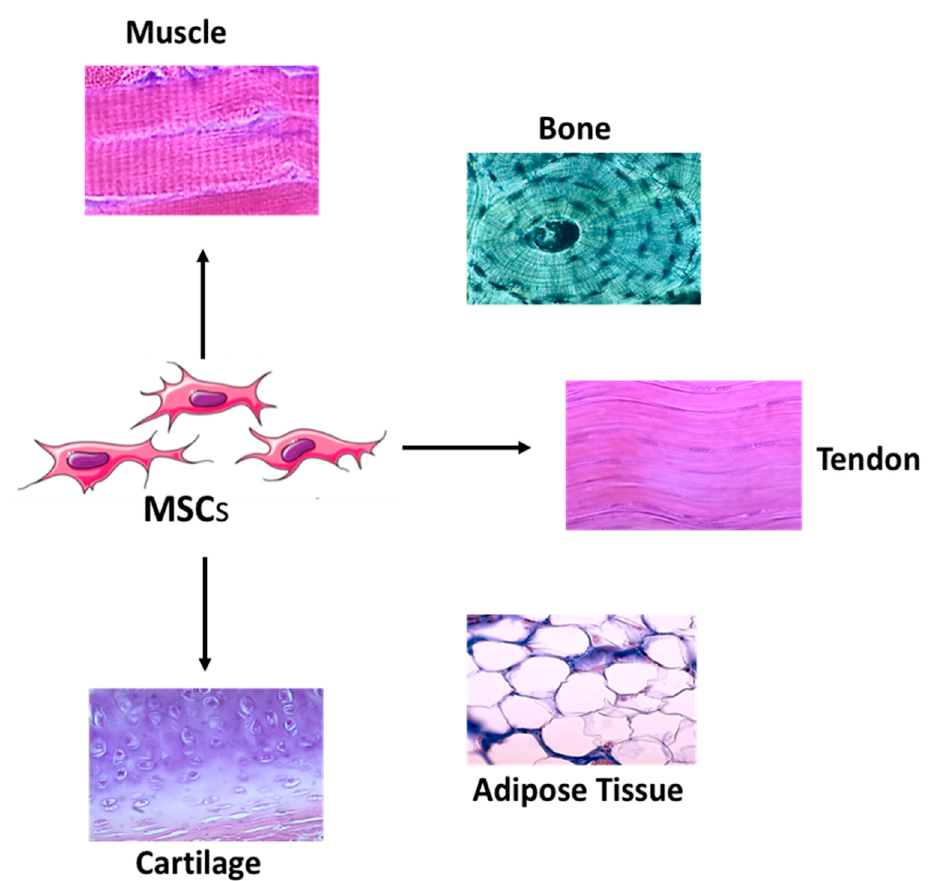
Figure 1. Mesenchymal stem cells, such as bone marrow-derived mesenchymal stem cells and adipose-derived stem cells have the potential to differentiate into various tissue lineages, making them invaluable tools in regenerative medicine and tissue engineering .